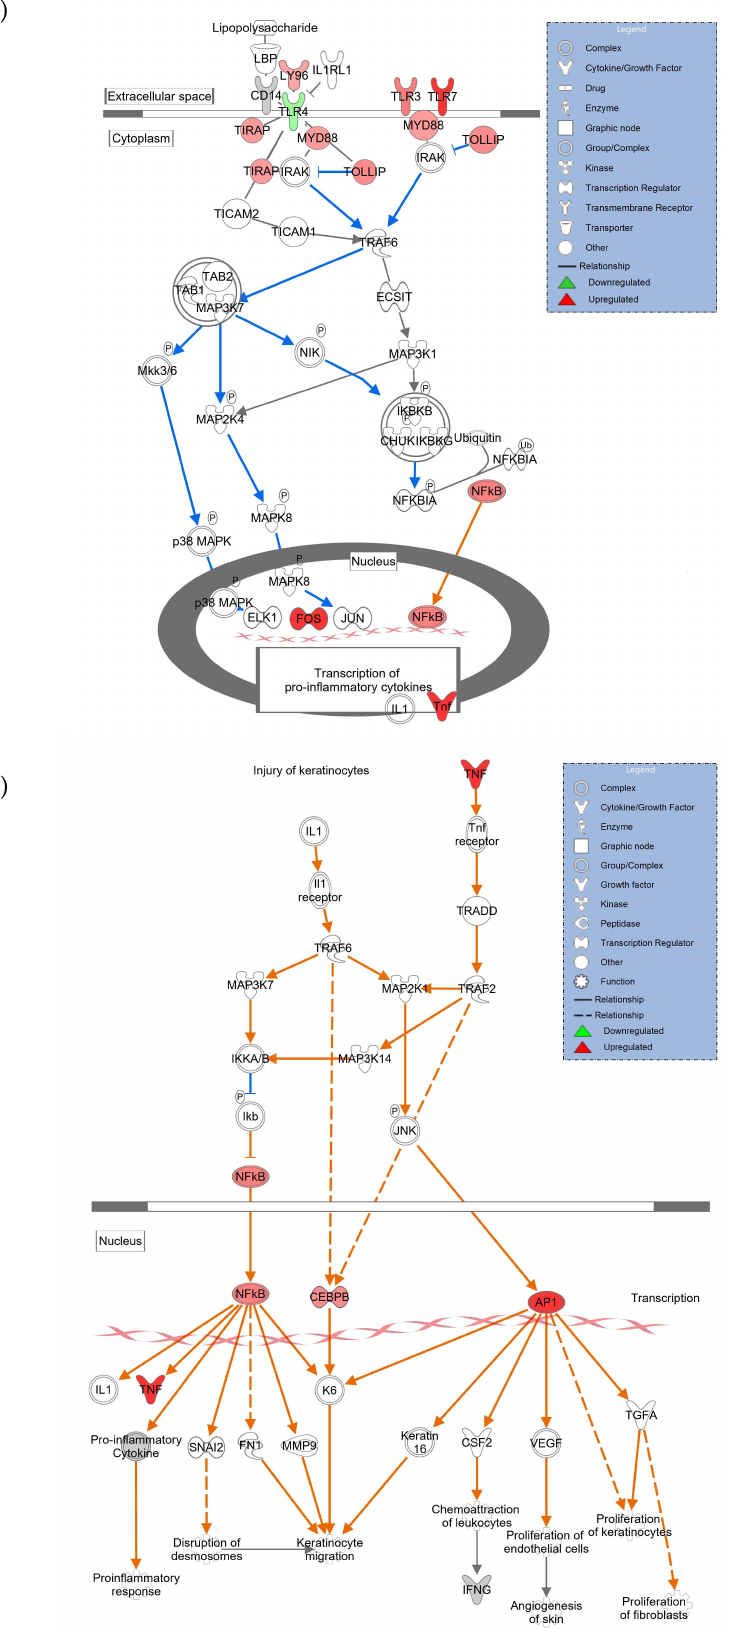
Figure 4. HDF cells were treated with 5 ng/mL LPS for 6 h followed by hASC exosomes or exosomes depleted of GAS5 for 18 h. LPS was maintained in the media and cells were harvested after 4 days. RNA was isolated and PCR was run using the Human Inflammation Array (Qiagen, cat #PAHS- 077Z). ( a ) Using GeneGlobe online data analysis software (Qiagen), a heatmap was generated from array data showing differentially expressed genes. ( b ) Genes identified from the heatmap showing patterns correlating to LPS, Exo, and Exo-G5 treatments were verified further by real-time qPCR. Relative quantification (RQ) was determined using a control sample as reference ( n = 3). Statistical